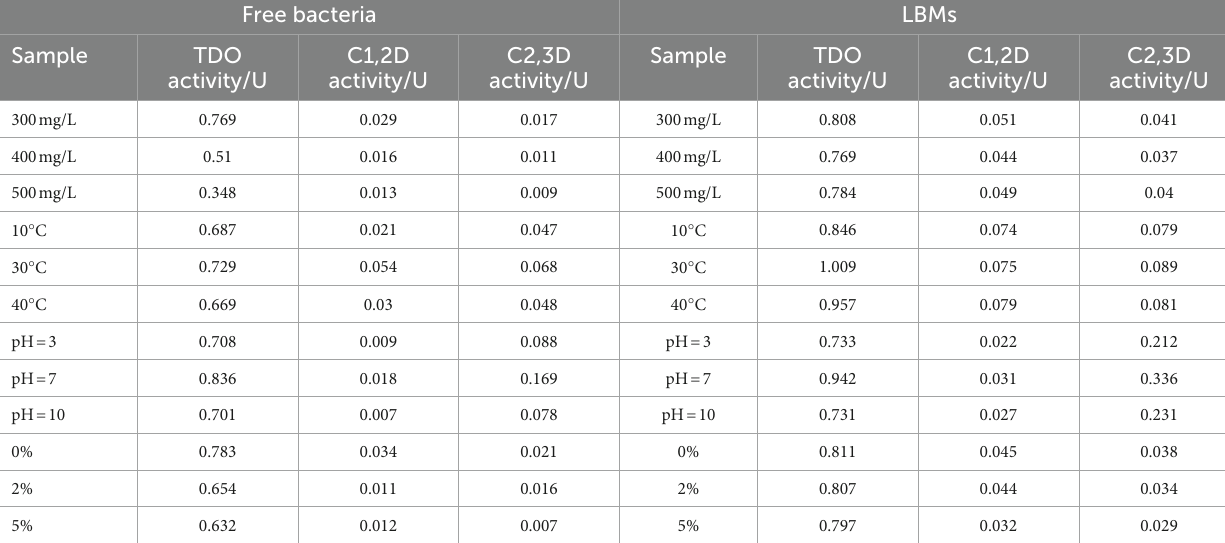
TABLE 3 Activity of TDO, C1,2D, and C2,3D in the free bacteria system and the LBMs system at the 5th day under different conditions. Free bacteria